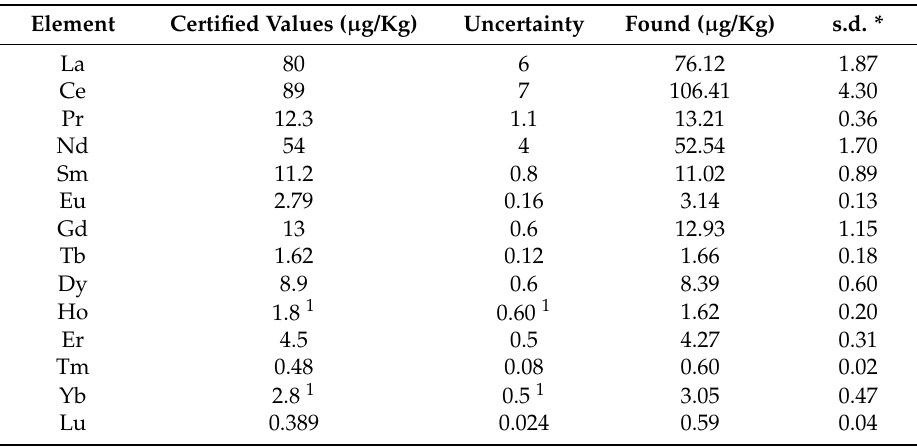
Table 1. Analysis of BCR 668 certified biological material (mussel tissue).